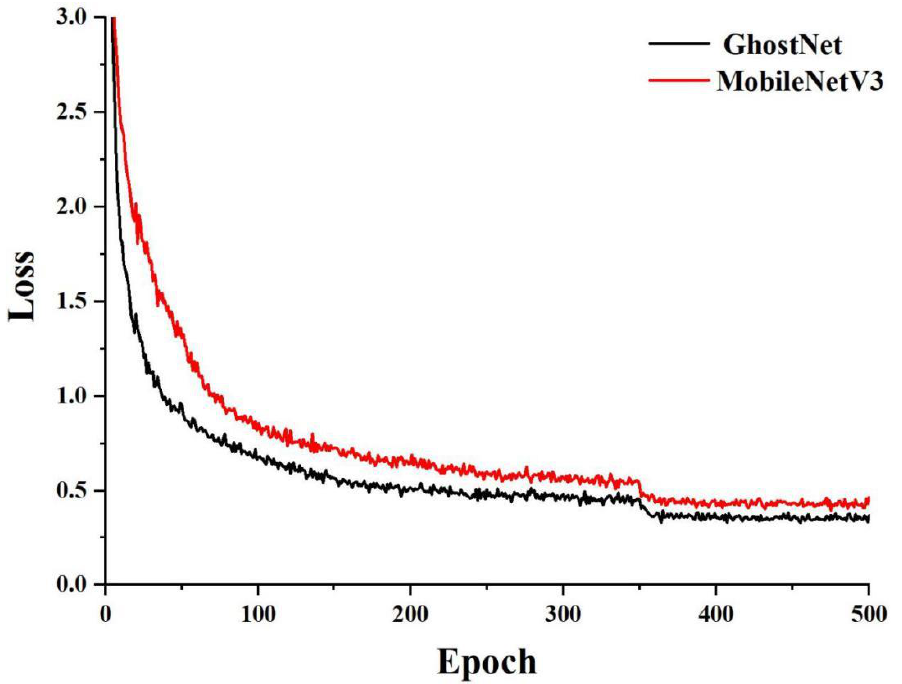
Figure 8. The training losses using different backbone networks.